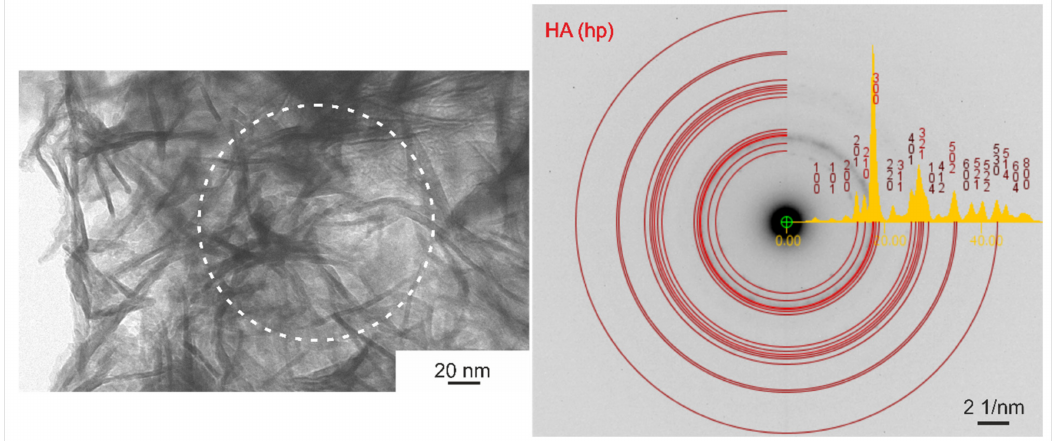
Figure 4. HA nano-particles and electron diffraction pattern from the area marked by the circle,